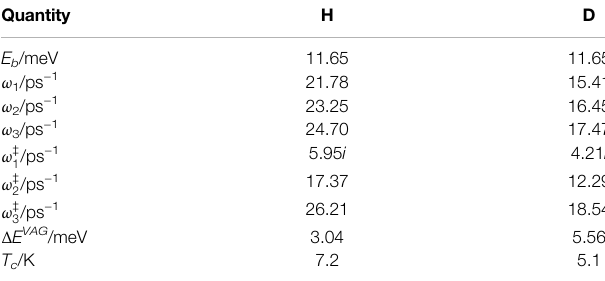
TABLE 1 | Data relating to the potential employed for protium ( 1 H (cid:1) H) and deuterium (D) atom motion on ice. E b isthe classical barrier height, the various ω ′ s are harmonic angular frequencies, ‡ indicates transition state, Δ E VAG is the vibrationally adiabatic ground state barrier height and T c is the cross-over temperature (Hänggi et al.,